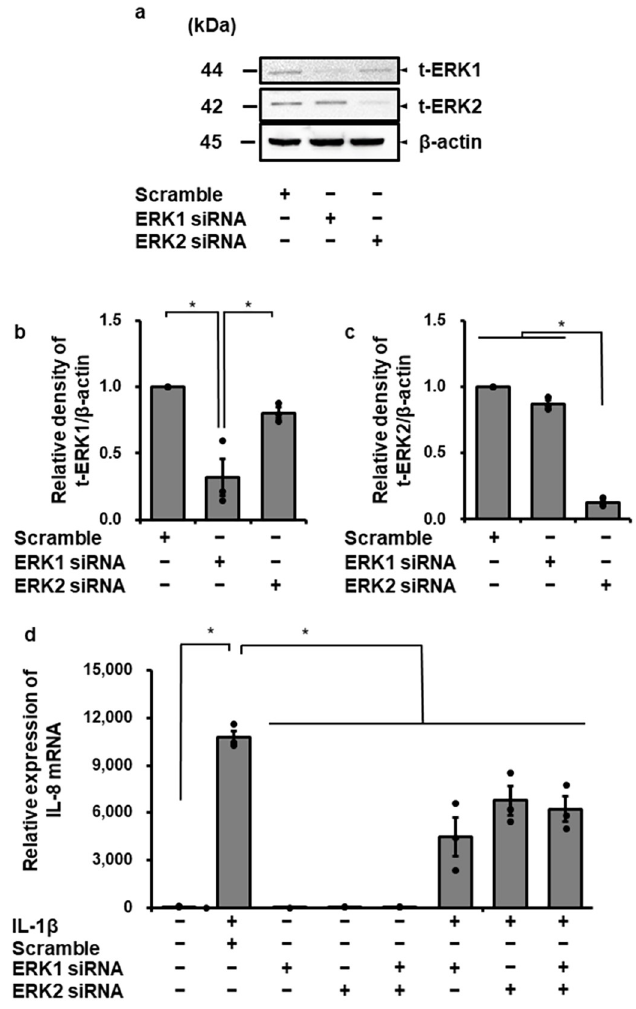
Fig 4. Attenuation of IL-1 β -induced IL-8 mRNA expression in canine dermal fibroblasts transfected with ERK1and ERK2 siRNAs. (a-c) In canine dermal fibroblasts transfected with ERK1, ERK2, and scrambled siRNAs, expression of t-ERK1, t-ERK2, and β -actin was detected by western blotting. The expression of ERK1 or ERK2 was reduced in cells transfected with ERK1 or ERK2 siRNA, respectively, but not in cells transfected with scrambled siRNA. β -actin was used as an internal standard. Representative results (a) and relative density of t-ERK1 or ERK2 protein expression in siRNA-transfected cells compared with those in scrambled siRNA-transfected cells (b, c) are depicted. (d) Dermal fibroblasts transfected with ERK1, ERK2 and scrambled siRNAs were incubated with or without IL-1 β (100 pM) for 6 h. After the incubation, IL-8 mRNA expression was determined. TBP was used as an internal standard. ERK1 and ERK2 siRNA transfection resulted in reduction of IL-1 β -induced IL-8 mRNA expression, while scrambled siRNA-transfection did not. In ERK1 and 2 double knockdown cells, IL-1 β -induced IL-8 mRNA expression was also attenuated. Results have been represented as mean ± SE from biological triplicates. � P < 0.05.